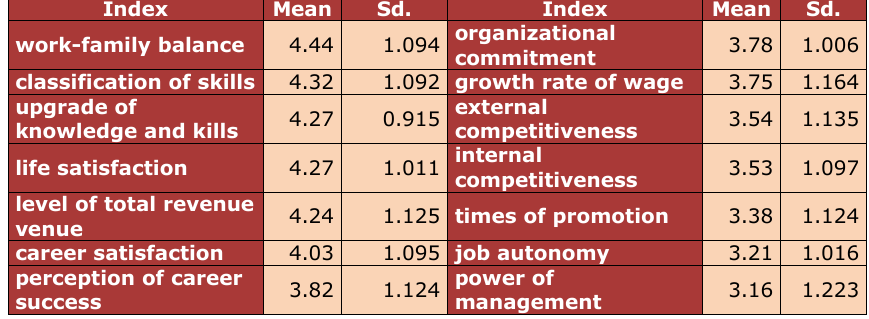
Table 3. Descriptive statistical analysis of career success of skilled